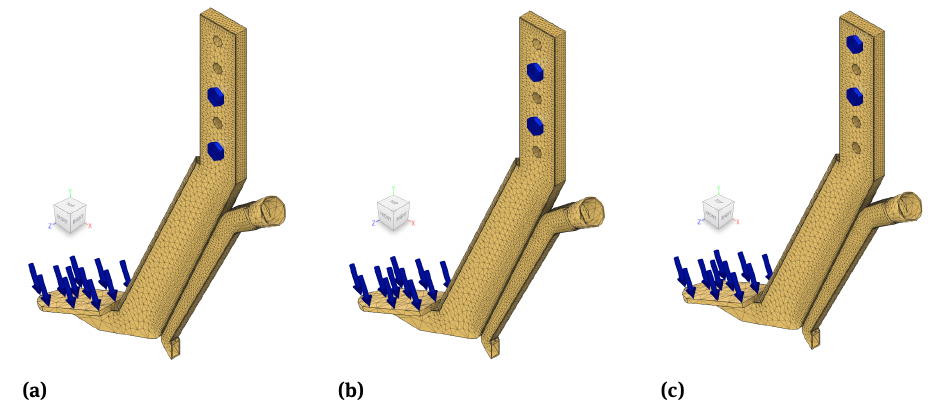
Figure 9: Boundary conditions a) – Depth – 0.15 m, load – 4500 N; b) – Depth – 0.20 m, load – 5000 N; c) – Depth – 0.25 m, load – 6000 N; the diameter of bolts connec- tor is 19 mm.